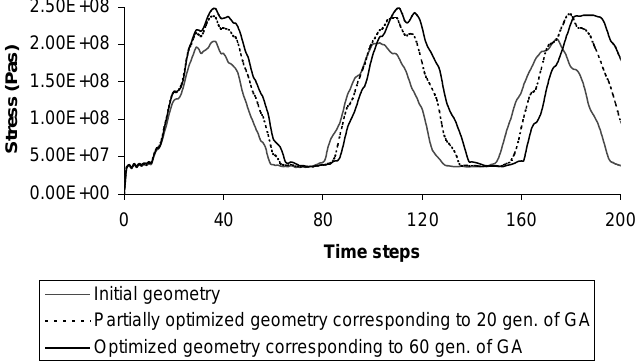
Fig. 16. Maximum Von-Mises stresses vs. time steps for different geometry of the simply supported beam during optimization process.